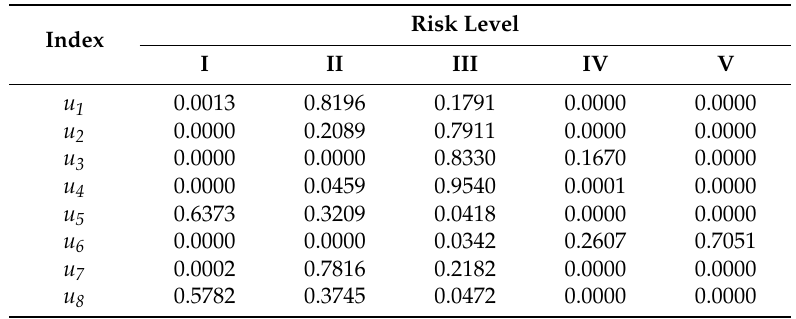
Table 13. Certainty degrees of Zunyi City in Guizhou province.